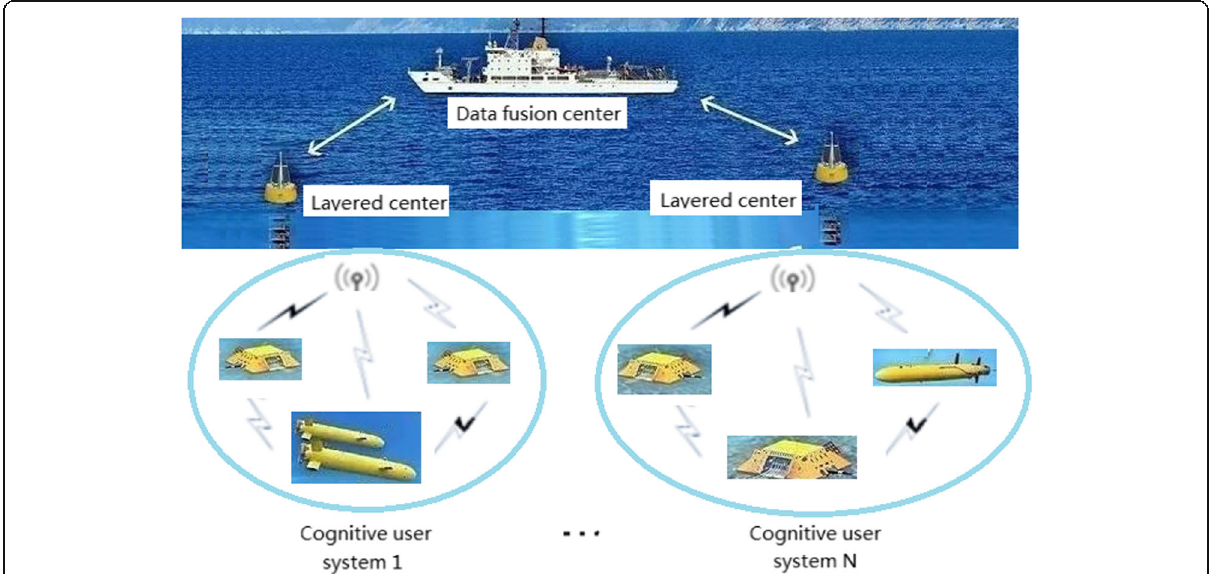
Fig. 1 Multi-layer structure model of an underwater communication system block diagram. When the signal detection is required, the control center will issue an indication signal, and all members of the grading center will perform the signal detection operation synchronously. Each SU collects the compressed data, uses the Bayesian model to obtain the shared super-parameters, and transmits the results to the cognitive radio user base station to obtain the preliminary signal detection results. When members of the hierarchical center collect perceptual data, distributed computing is performed and the results are broadcast to the hierarchical control center. After a lot of information exchange, the frequency spectrum of the spectrum signal detection algorithm is proposed to be close to a fixed value, the next step is through the data fusion center on the individual level data fusion, the center of the implement multiple layers joint spectrum signal detection, this paper puts forward a kind of based on Dirichlet process (DP) hierarchical Bayesian model to achieve compression perception. The data are grouped and the shared super- parameters are mined in each group to obtain the optimal signal detection